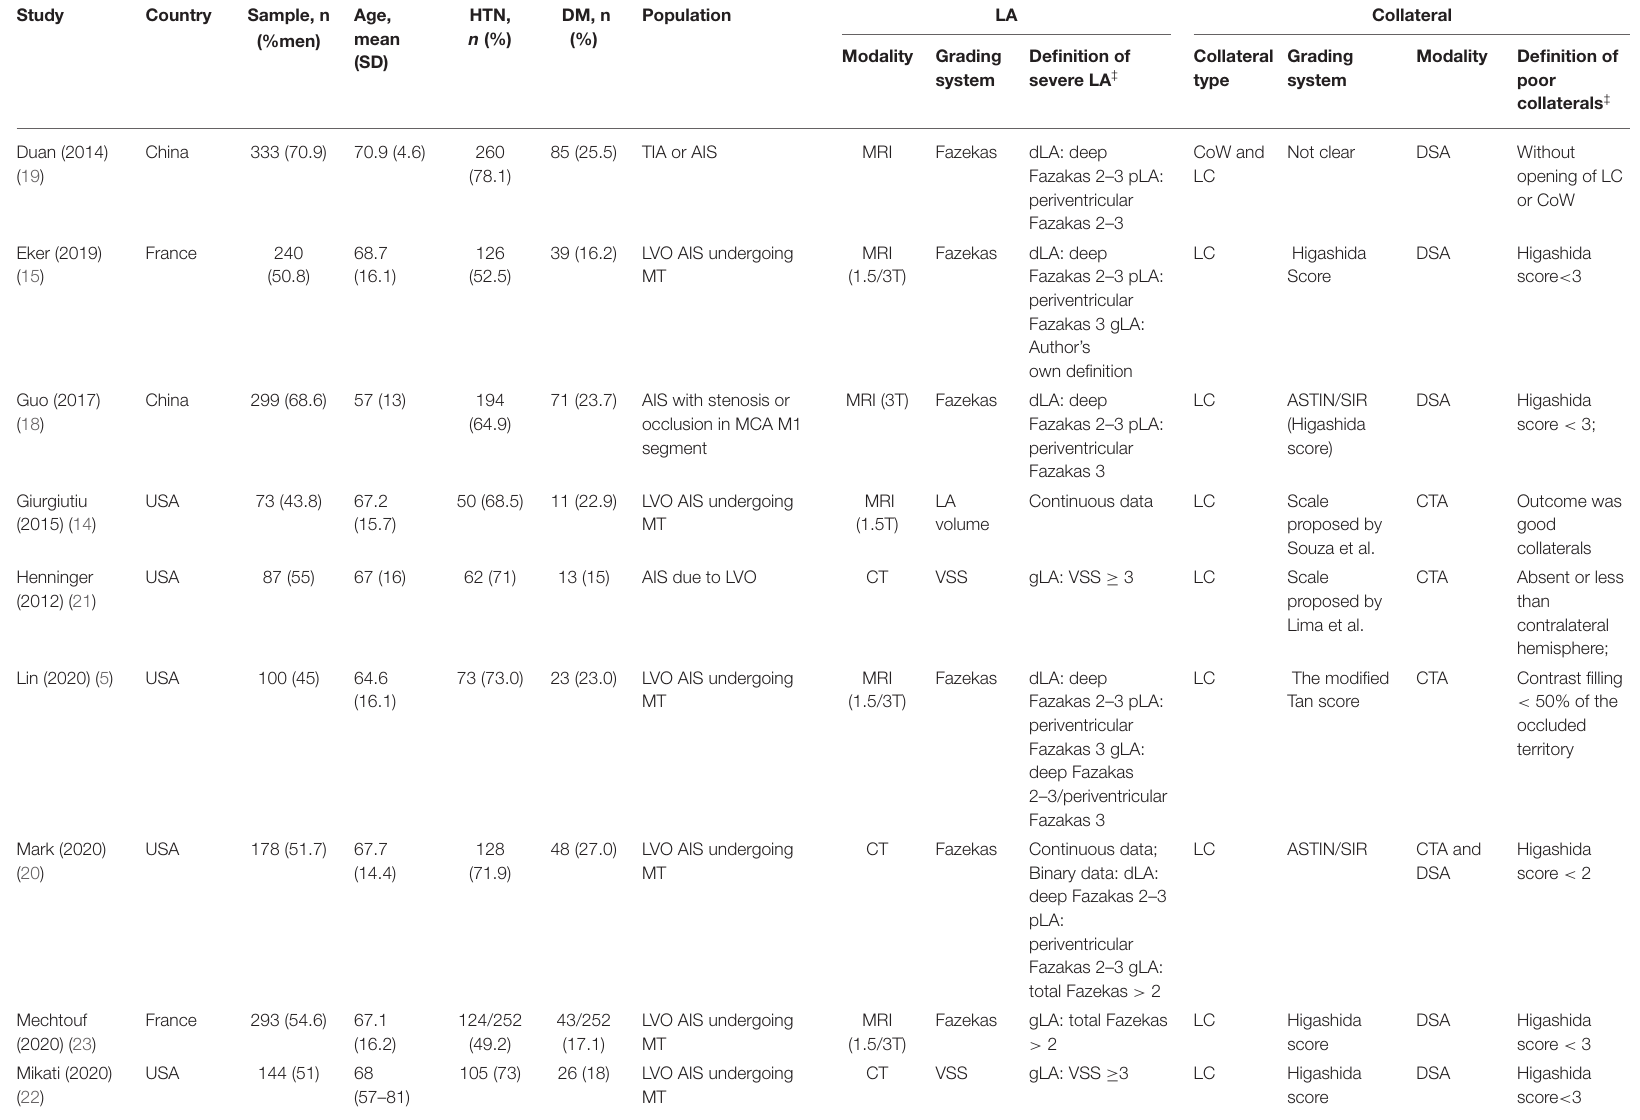
TABLE 1 | Characteristics of the included